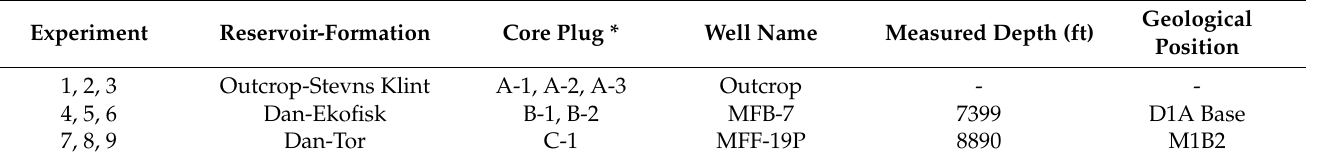
Table 2. Rock materials, well name, and depth of core plugs.